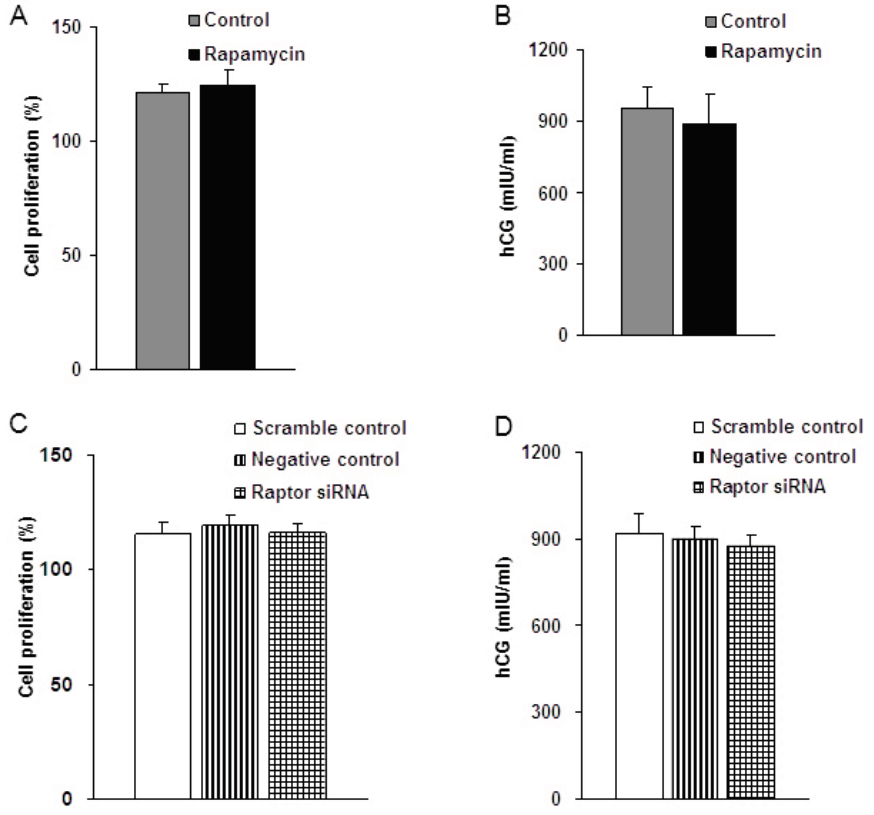
Figure 3. Rapamycin and raptor silencing does not affect JEG-3 cell characteristics. ( A ) Effect of rapamycin on JEG-3 cell proliferation; ( B ) Effect of rapamycin on the hCG secretion of JEG-3 cells. Values are mean ± SD. n = 10, p > 0.05 by Mann-Whitney U -test; ( C ) Effect of raptor silencing on JEG-3 cell proliferation; and ( D ) Effect of raptor silencing on the hCG production of JEG-3 cells. Values are means ± SD. n = 10, p > 0.05 by Kruskal-Wallis